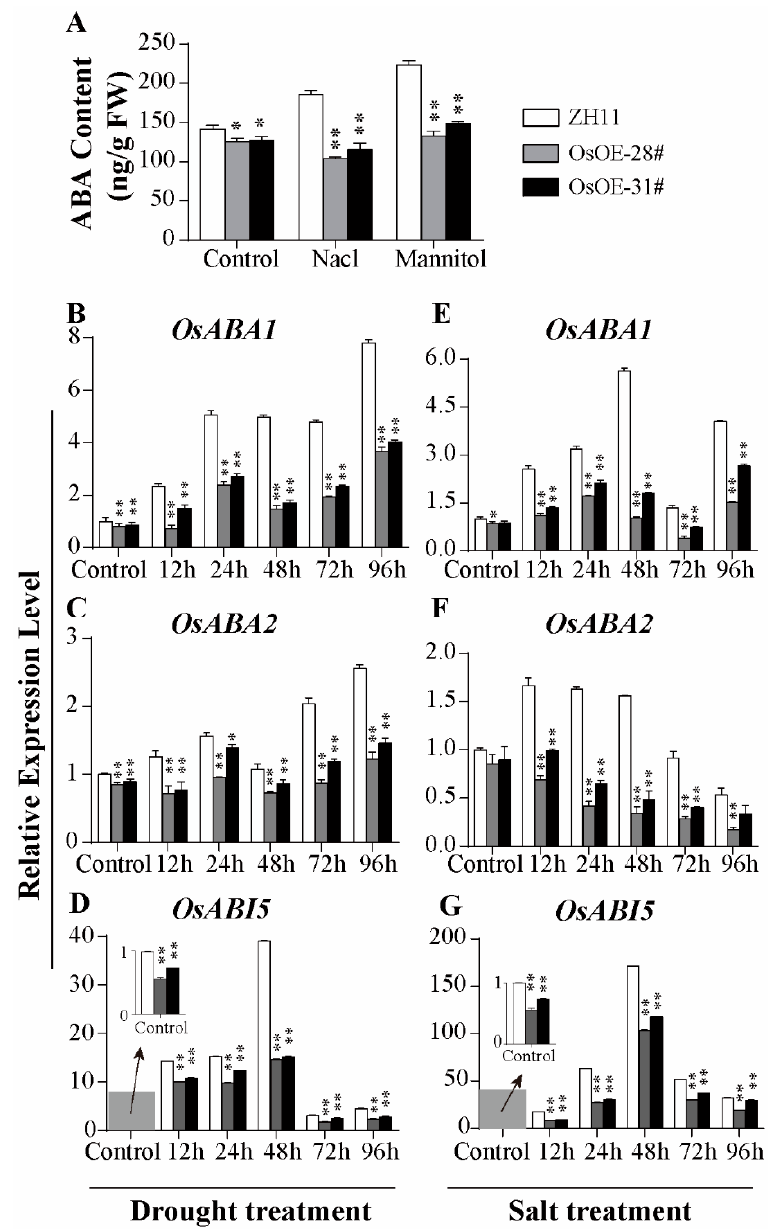
Figure 7. Determination of ABA content and expression level of ABA signal pathway genes in transgenic rice lines. ( A ) The endogenous ABA levels of transgenic rice lines and wild-type leaves were determined by LC-MS under normal, salt, or drought conditions for 48 h, respectively. The expression levels of OsABA1 , OsABA2 , and OsABI5 in WT, OsOE-28#, and OsOE-31# under ( B – D ) mannitol or ( E – G ) NaCl treatment. The error bars indicate + SD ( n = 3 replicates). Asterisks indicate significant differences for the indicated comparisons based on Student’s t-test (** p < 0.01; * p < 0.05).